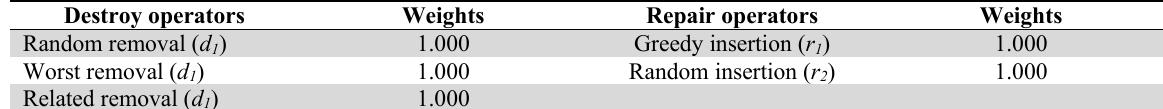
Destroy and repair operators for proposed algorithm